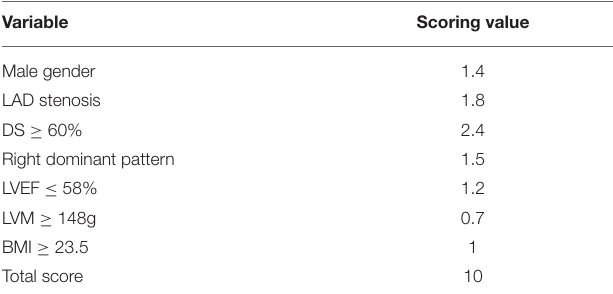
TABLE 8 | The distribution of the scoring form.